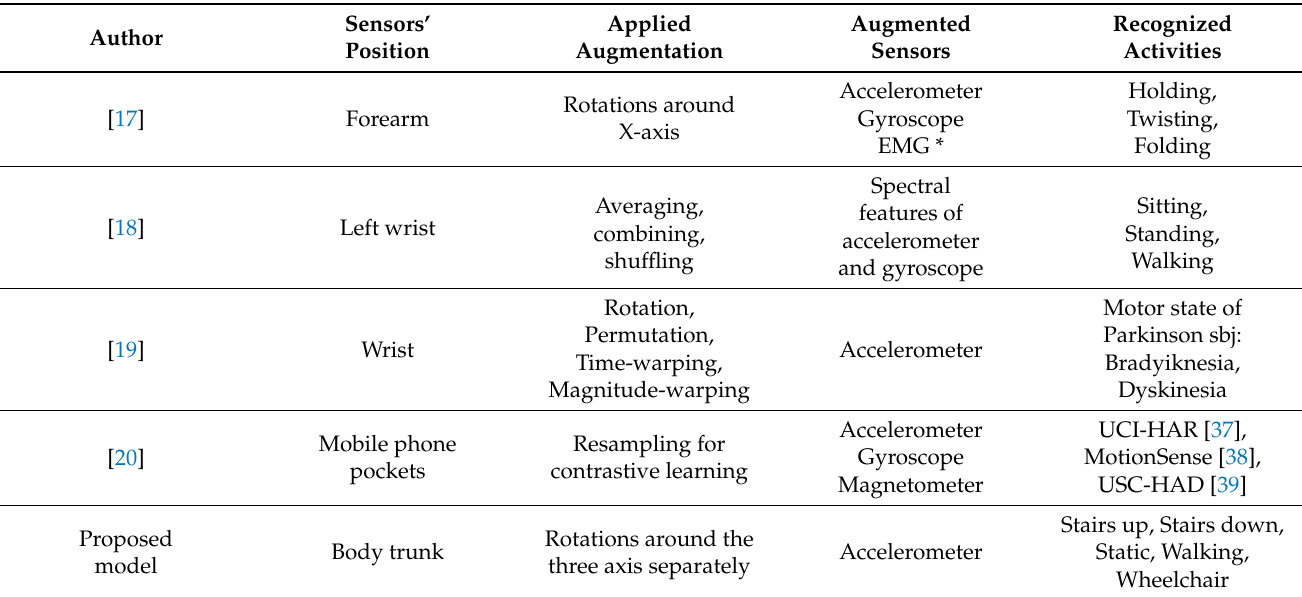
Table 4. Description of the most relevant studies related to wearable sensor data augmentation in the context of HAR. Each study is described by its sensors’ positioning, applied augmentation, type of sensor, and recognized